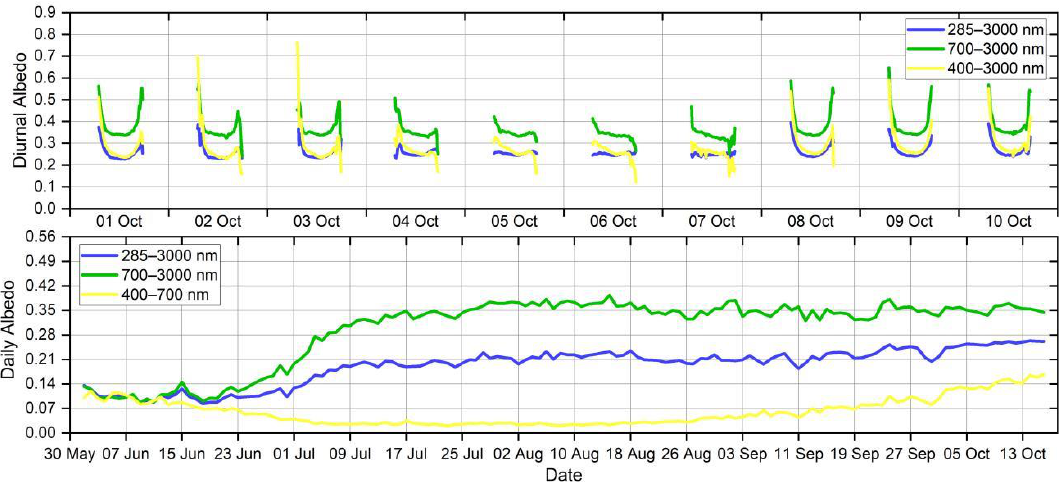
Figure 3. Variations in sample diurnal albedo (1 – 10 October) and seasonal daily albedo.